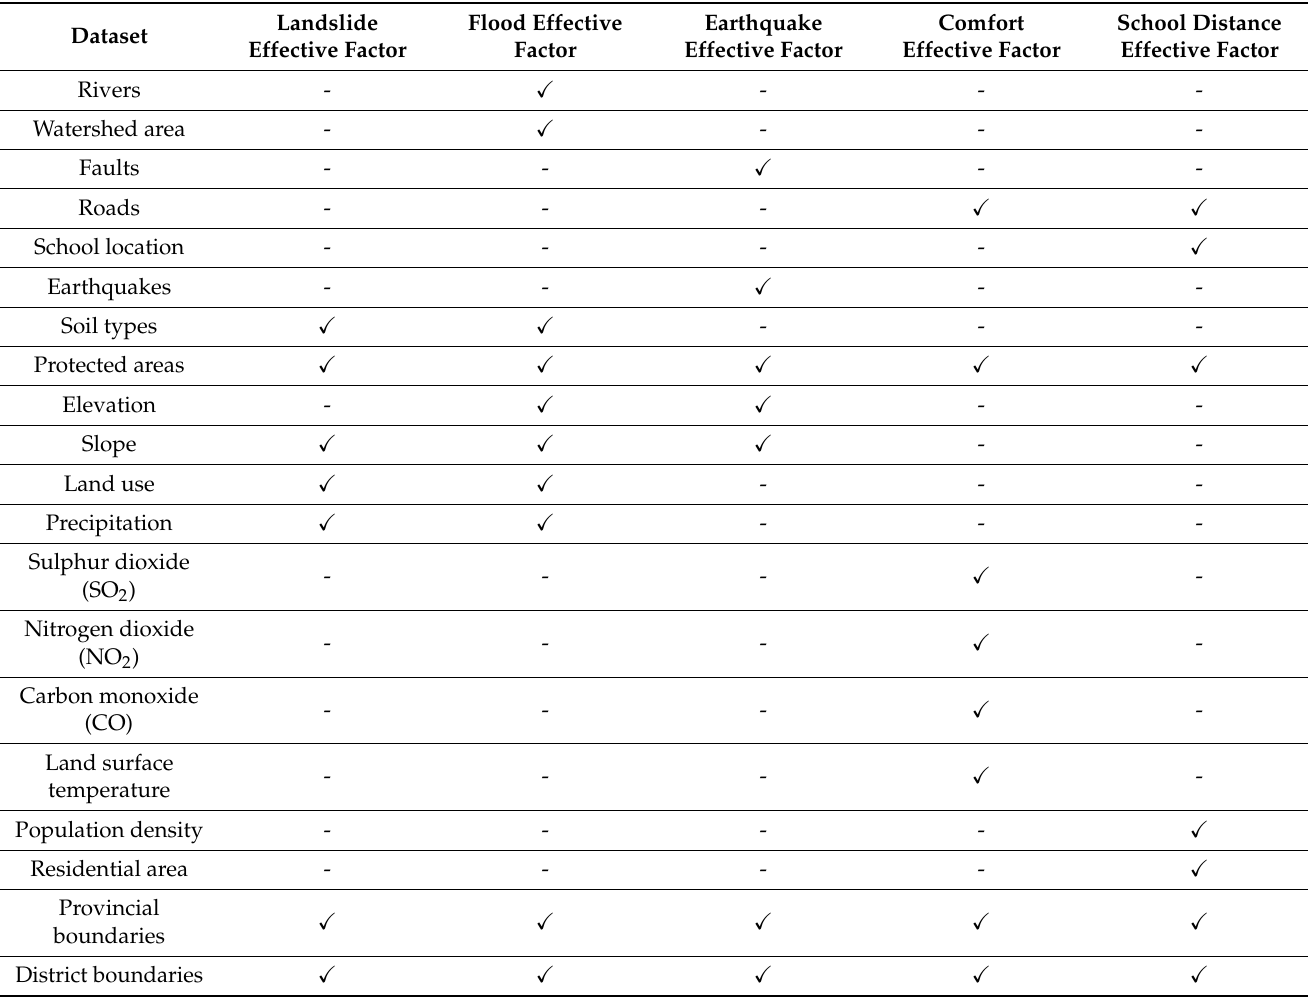
Table 2. Dataset use in the present research